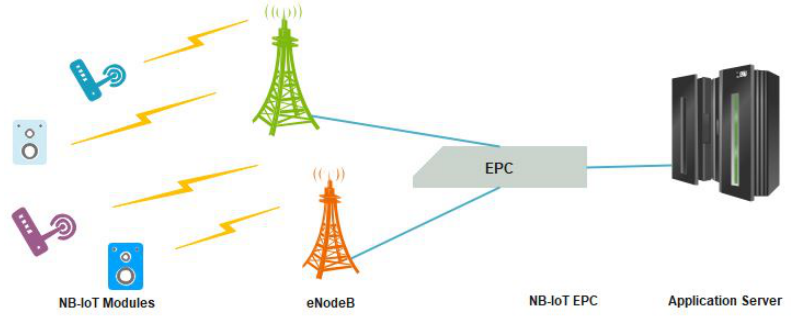
Figure 3. The Infrastructural Architecture of NB-IoT